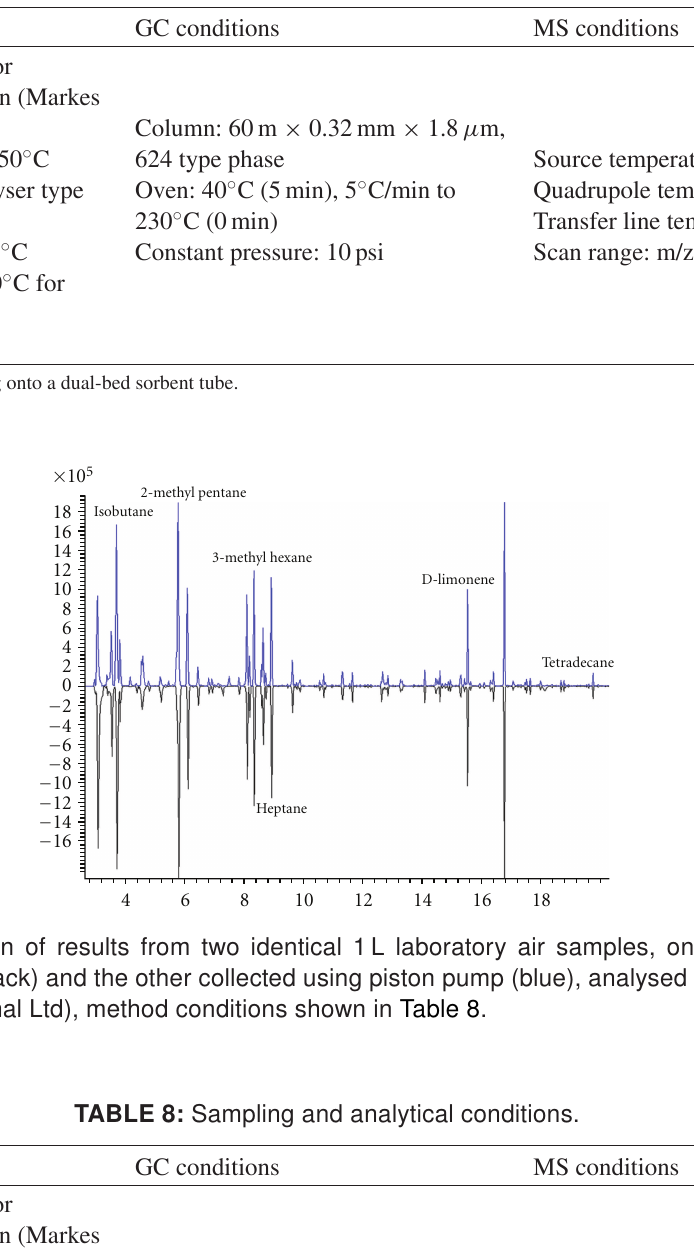
TABLE 7: Sampling and analytical conditions.